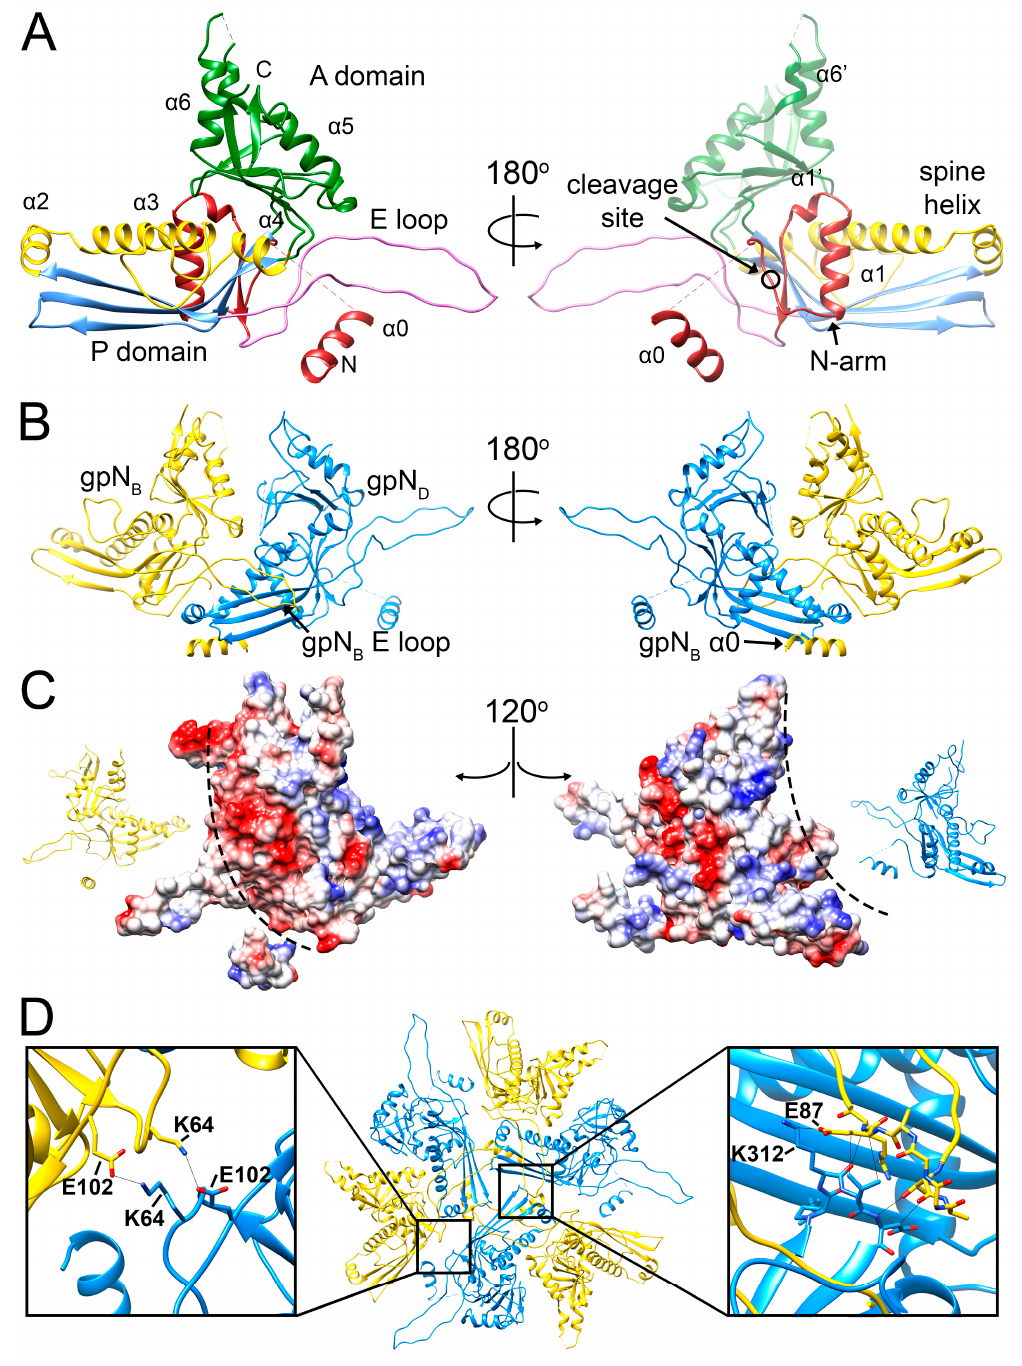
Figure 3. The gpN capsid protein. ( A ) Ribbon diagram of gpN B (the most complete subunit), colored by structural feature: N-arm, red; E-loop, pink; P-domain β -sheet, blue; P-domain α -helices, yellow ( α 3 is the spine helix); A-domain, green. The right-hand panel is rotated by 180 ◦ . Key structural features are labeled, and the gpO cleavage site between residues 31 and 32 is indicated (circle). ( B ) Intra-capsomer interaction between the gpN B (yellow) and gpN D (blue) subunits, showing how the gpN B E-loop overlays the spine helix of the neighboring (gpN D ) subunit. The right-hand panel is rotated by 180 ◦ and shows how the gpN B N-arm and α 0 grasp the P-domain of gpN D from underneath. ( C ) Electrostatic surfaces for the gpN B and gpN D subunits from panel B, separated and rotated by 120 ◦ in opposite directions, as indicated by the insets. Interaction surfaces of opposite charge are indicated by the dashed lines. ( D ) Inter-capsomeric interaction between three gpN D and their neighboring gpN B subunits related by the icosahedral threefold axis. The insets show details of the interactions between the gpN D and gpN B